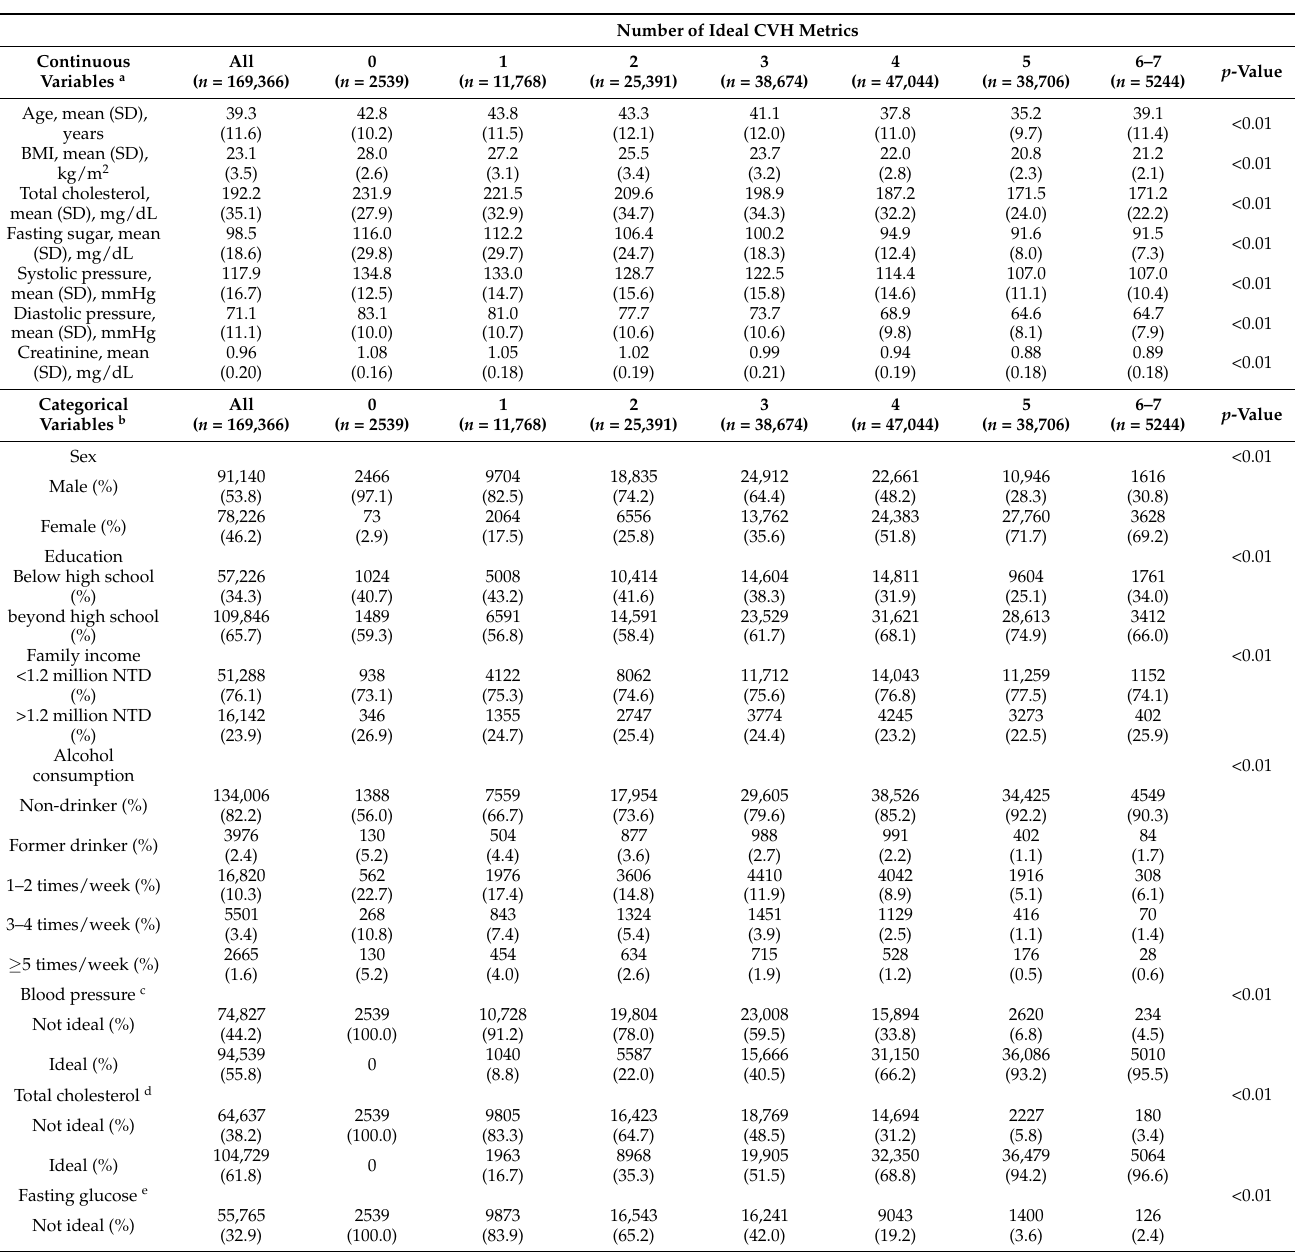
Table 2. Characteristics of the study